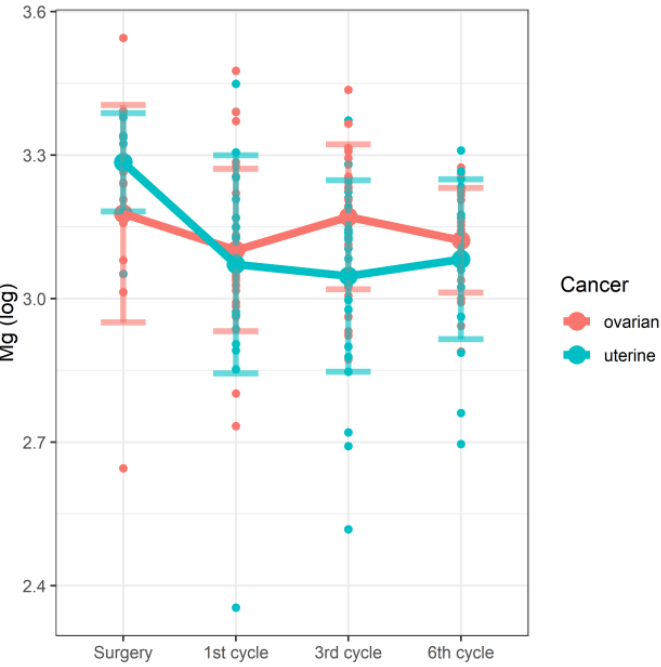
Figure 1. Changes in Mg concentrations (log) by the stage of therapy and the type of cancer.